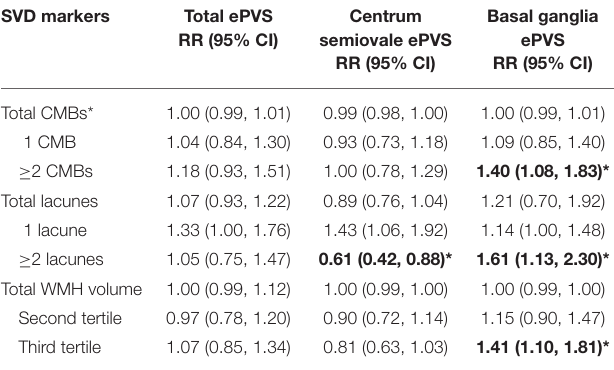
TABLE 4 | Association between severity of SVD and ePVS (EDIS).